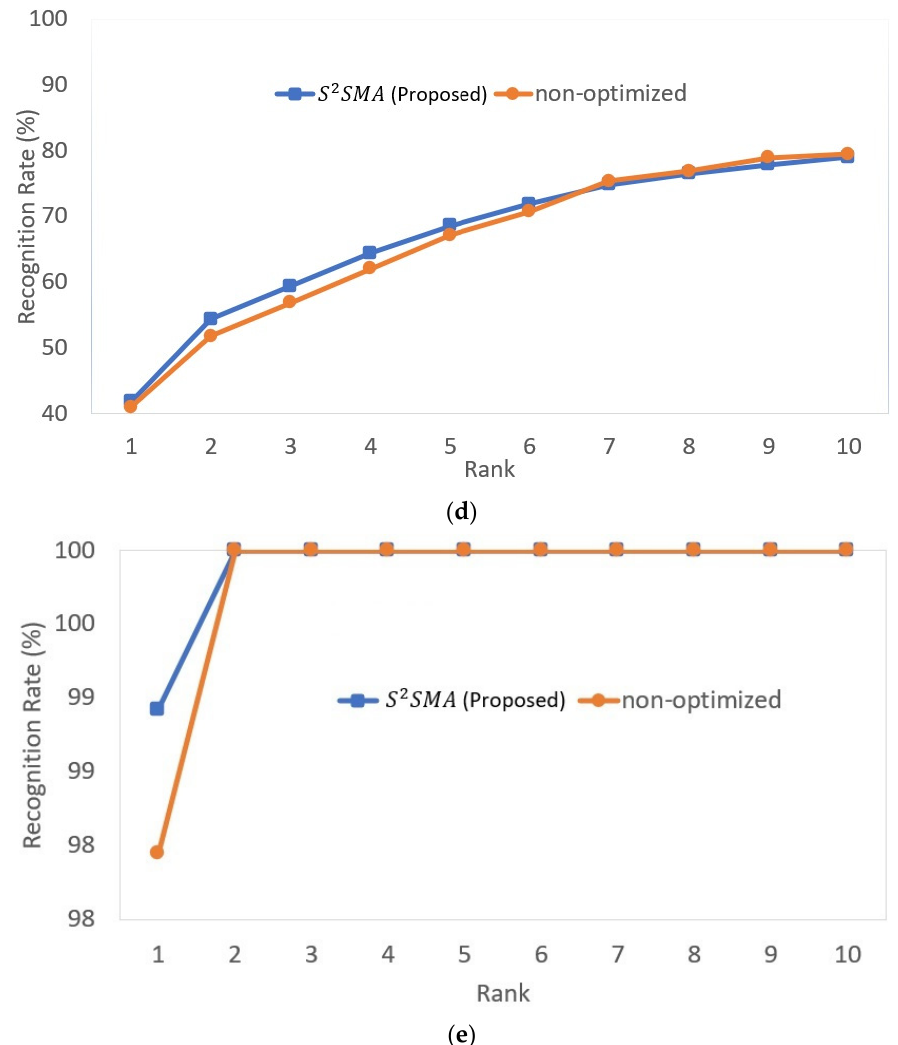
Figure 12. The CMC results of S 2 SMA as compared with non-optimized for ( a ) FaceNet, ( b ) ArcFace, ( c ) VGG-Face, ( d ) DeepFace, and ( e ) multiple-model.